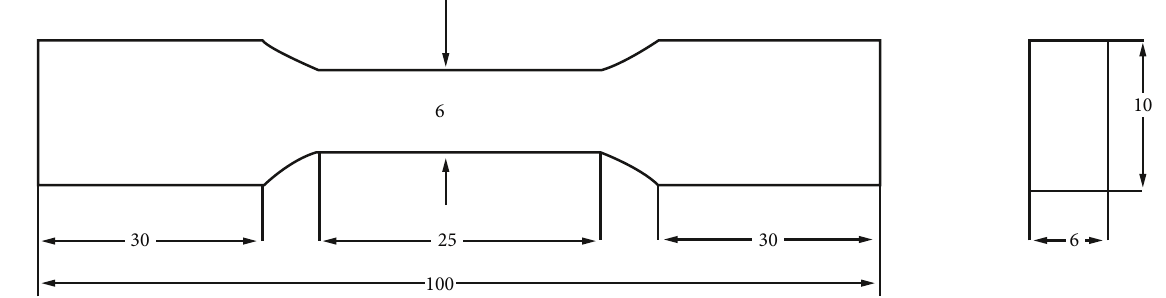
Figure 3: Tensile specimen’s dimensions.